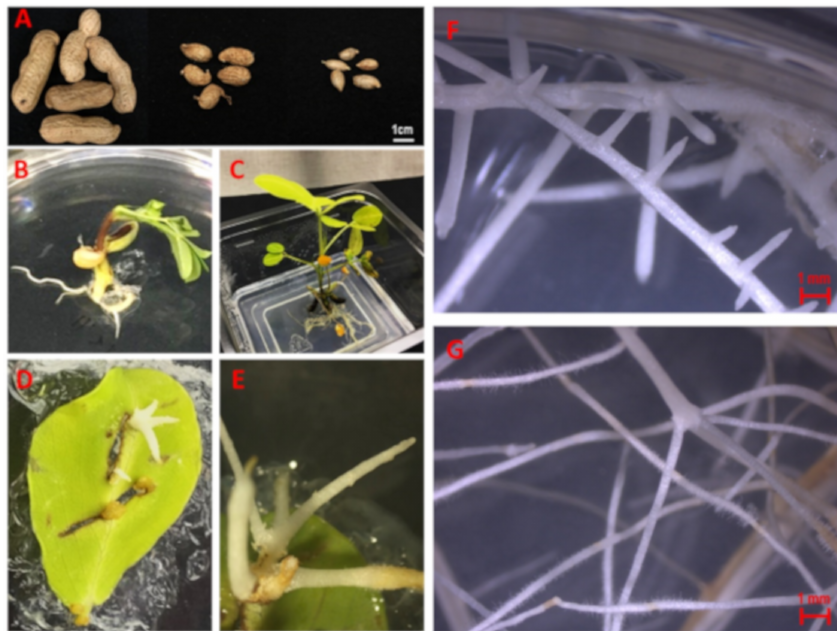
Figure 4. ( A ) Seed pods of Arachis hypogaea (left), A. ipaensis (center) and A. duranensis (right). ( B ) Two-week-old seedling of wild Arachis . ( C ) Eight-week-old seedling of wild Arachis . ( D , E ) Hairy root development from leaf infected with Agrobacterium rhizogenes . ( F ) Phenotype of A. ipaensis hairy root line E4. ( G ) Phenotype of A. duranensis hairy root line